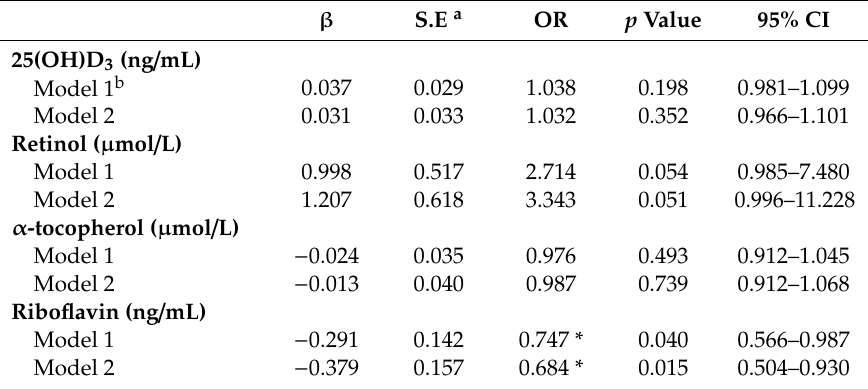
Table 4. Association between nutritional biomarkers and postpartum